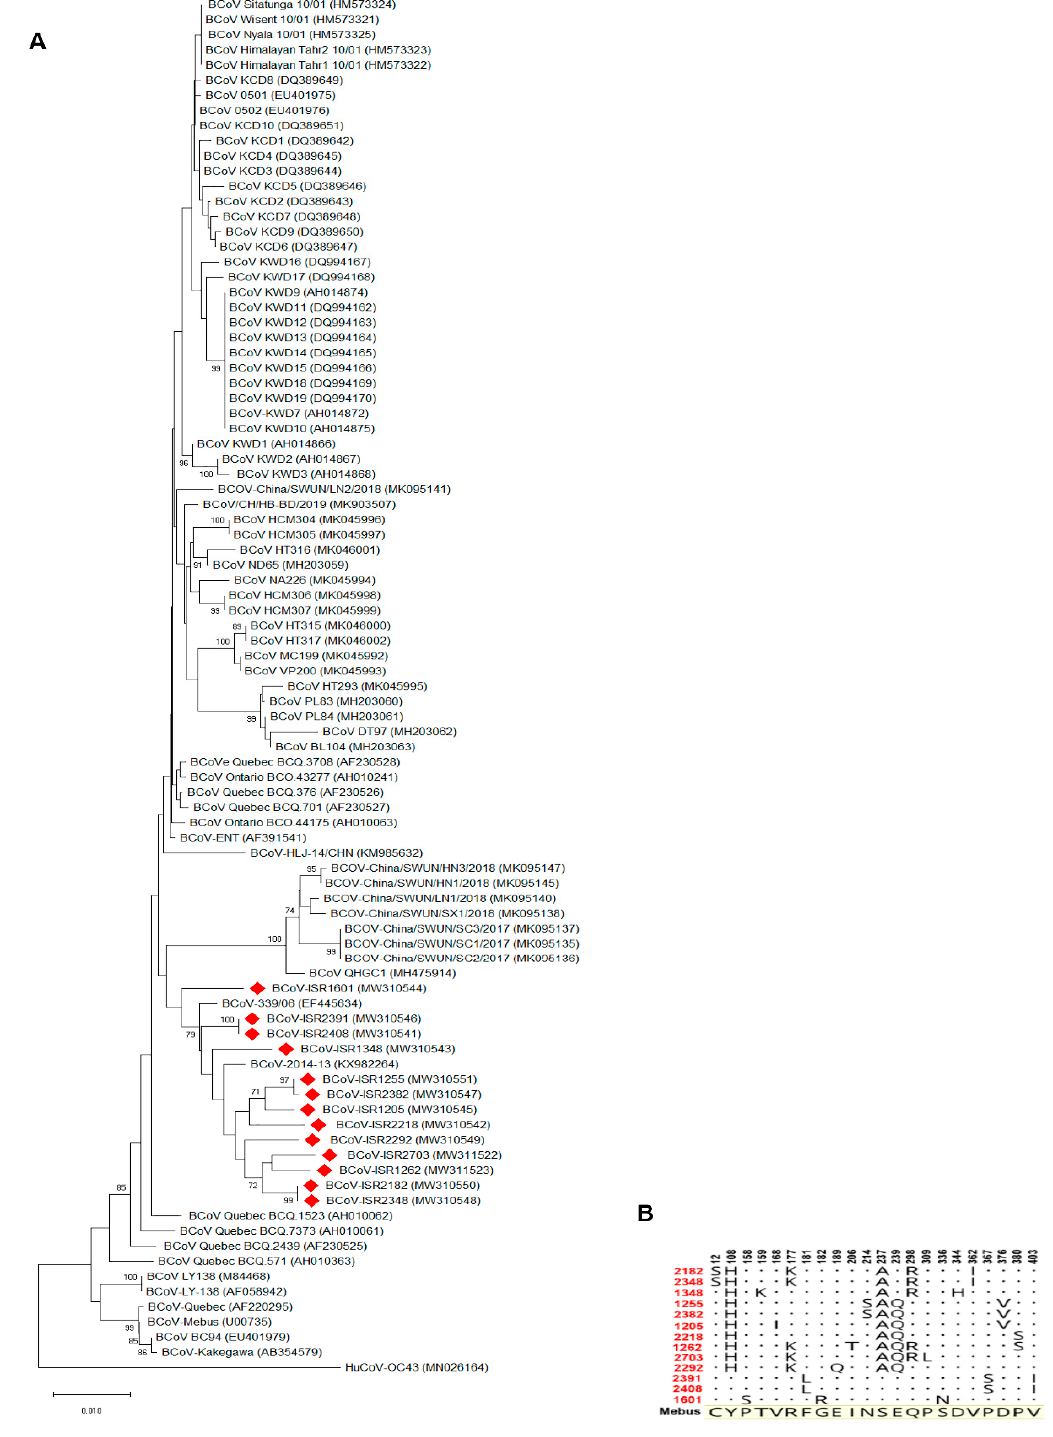
Figure 3. Phylogenetic tree of the Hemagglutinin Esterase (HE) gene of Bovine coronavirus (BCoV). Local isolates. ( A ) Local strains’ (labeled in red) alignment with selected reference BCoV HE sequences. Phylogenetic tree was generated based on full HE gene sequences. Phylogenetic trees were generated via the neighbor-joining method with bootstrap analysis (1000 replicates, >70%). The scale bar shows the number of substitutions per site. We used HCoV OC43 as an outgroup strain. HE sequences retrieved from GenBank and embedded in the figure for each strain. ( B ) Deduced amino acid sequences of local isolates aligned to reference strain Mebus. Amino acid alignment showing only disagreements residues compared to reference strain Mebus.